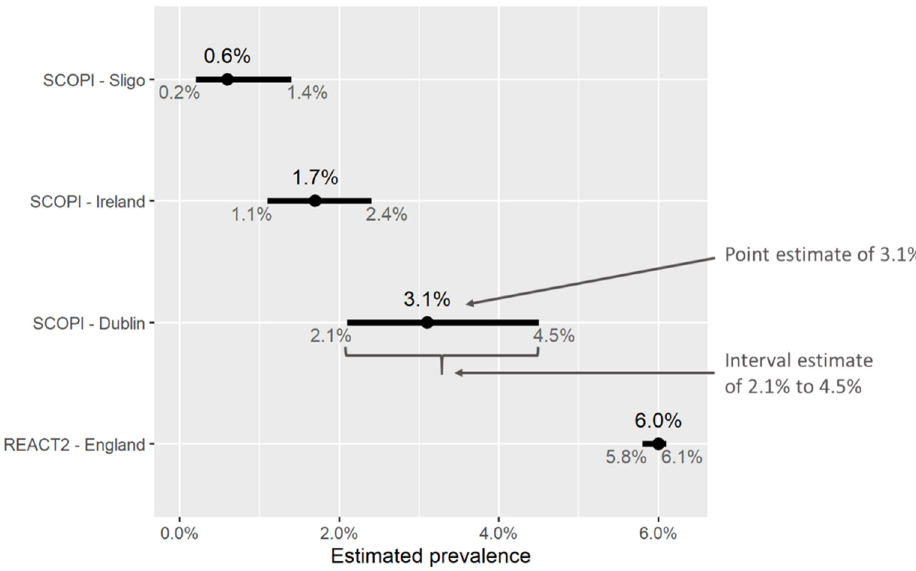
Figure 3. Point and interval estimates of seroprevalence from two studies, SCOPI [24] in Ireland and REACT2 [51] in England. Based on a sample of 913 people in Dublin, the SCOPI study esti- mated seroprevalence at 3.1%. The corresponding interval estimate indicates that the true value of seroprevalence in the wider population in Dublin was likely to lie between 2.1% and 4.5%. By contrast, the REACT2 study in England enrolled a large number of participants (ca. 100k), and thus the corresponding confidence interval for seroprevalence is narrow—greater sample sizes give more precise estimates (provided they are indeed representative of the population).